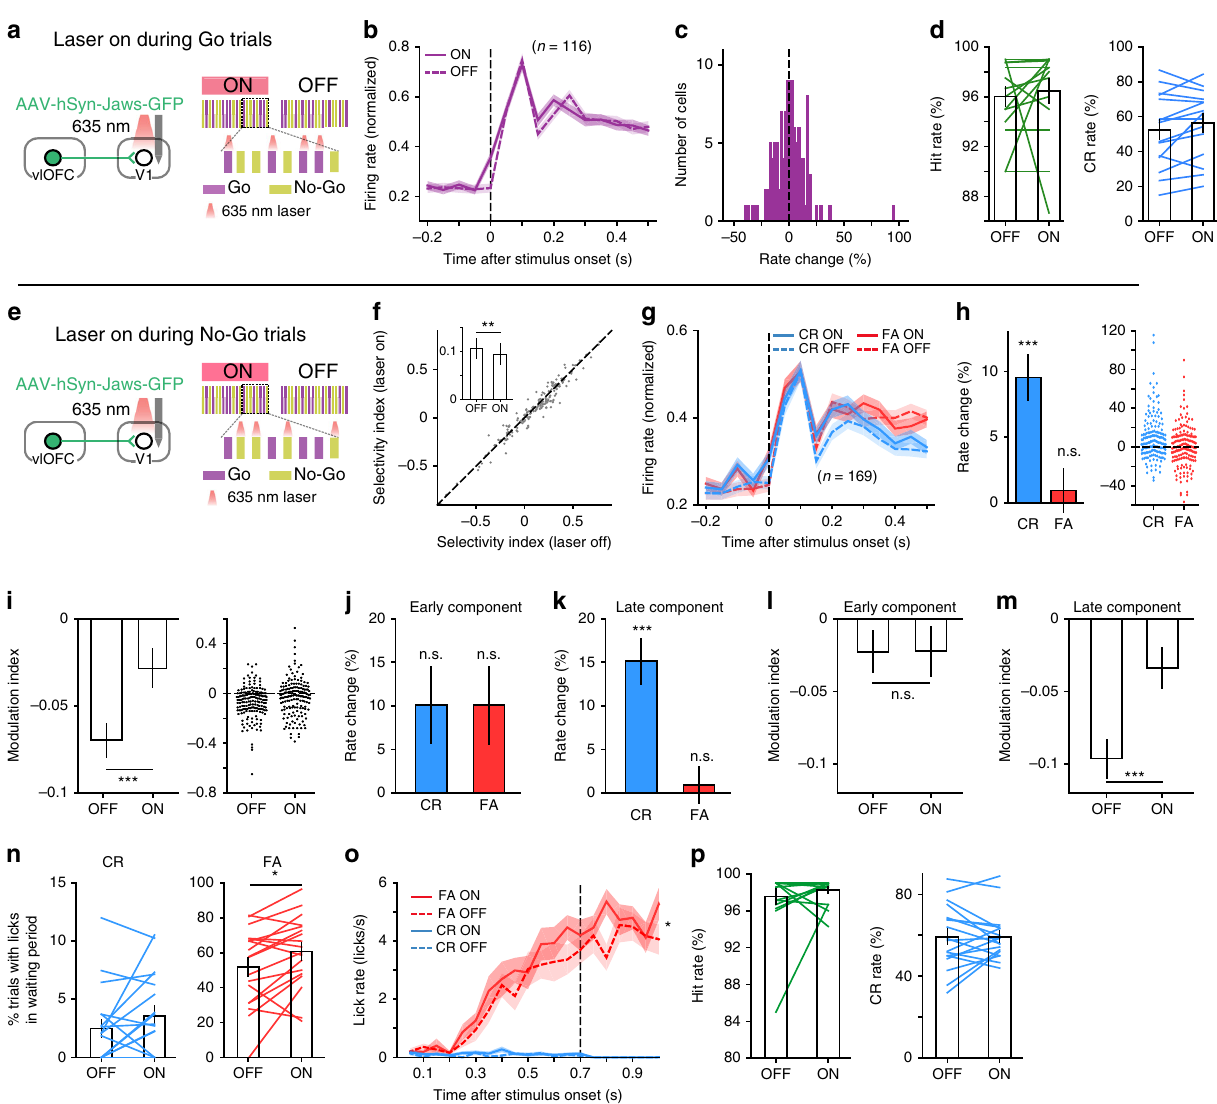
Fig. 4 Effect of inactivating OFC top-down projection on V1 responses. a Schematic of laser stimulation. b Normalized responses to Go stimulus with and without inactivating OFC axons. c Distribution of rate change induced by inactivating OFC axons during Go trials. P = 0.87, n = 116 neurons. d Inactivating OFC axons during Go trials did not affect hit rate ( P = 0.26) or CR rate ( P = 0.11, n = 15 sessions from seven mice). e Schematic of laser stimulation. f Inactivating OFC axons during No – Go trials signi fi cantly reduced the SI of V1 neurons (** P = 0.007, n = 169). g Normalized responses to No – Go stimulus in FA and CR trials, respectively, with and without laser stimulation. h Inactivating OFC axons during No – Go trials increased the responses of V1 neurons in CR (*** P = 1.02 × 10 − 6 ) but not in FA trials ( P = 0.66). n = 169 neurons. i Inactivating OFC axons during No – Go trials signi fi cantly reduced MI amplitude (*** P = 6.4 × 10 − 4 , n = 169 neurons). j Rate change for early response component (CR, P = 0.18; FA, P = 0.77). k Rate change for late response component (CR, *** P = 2.4 × 10 − 5 ; FA: P = 0.75). l Laser-off vs laser-on MI for early component ( P = 0.78). m Laser-off vs laser- on MI for late component (*** P = 6.4 × 10 − 5 ). n Effect of laser stimulation during No – Go trials on the percentage of trials with licks in the waiting period. CR, P = 0.14; FA, * P = 0.02. o Effect of laser stimulation on lick rate during waiting period. FA, F (1,17) = 7.78, * P = 0.01; CR, F (1,17) = 1.6, P = 0.22,